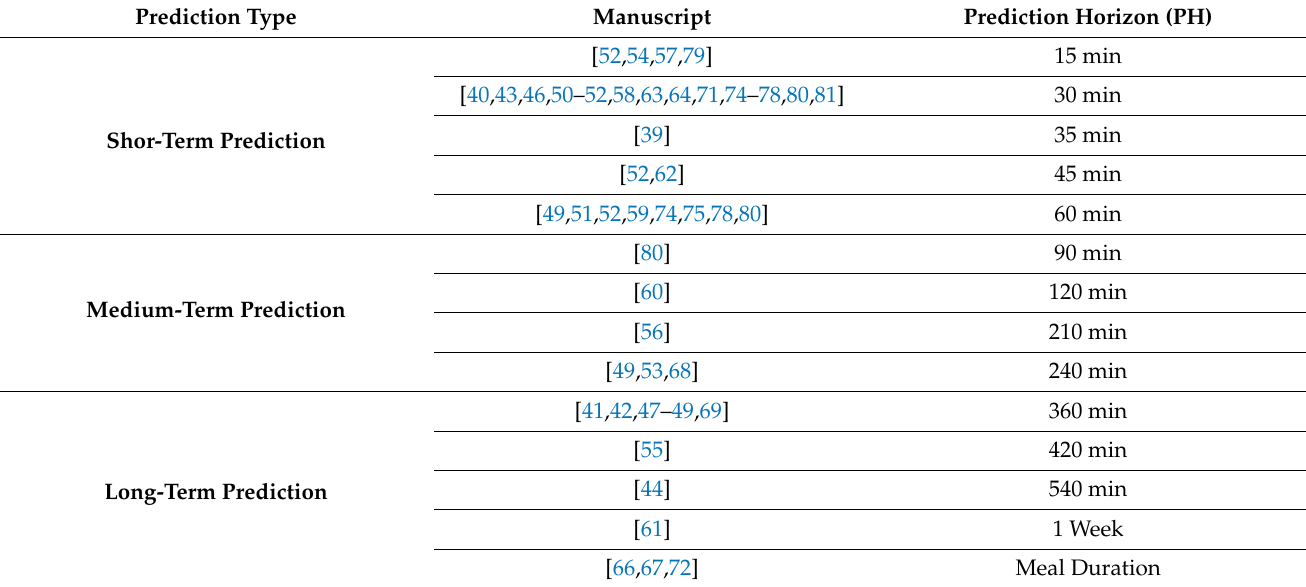
Figure 4. Different types of PH categories used in the studies. Table 3 . Prediction horizons used by different works .